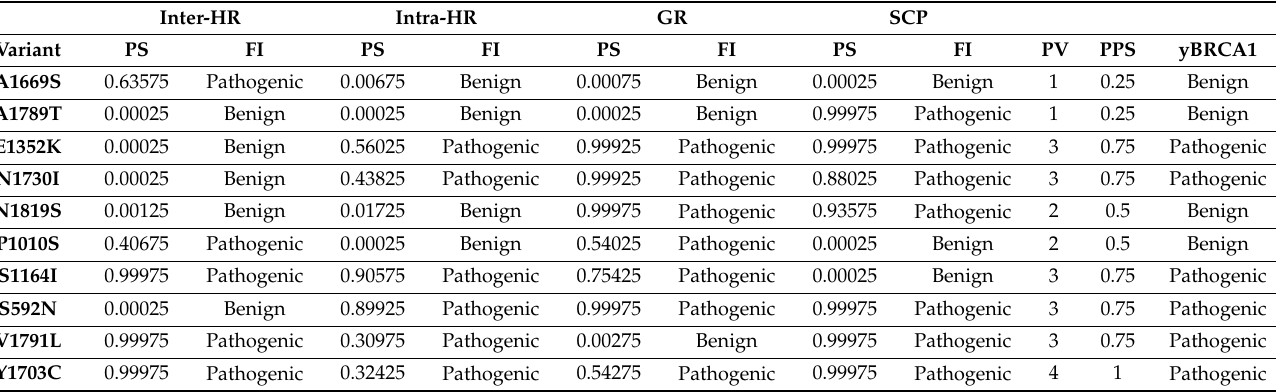
Table 3. Pathogenic prediction of VUS by